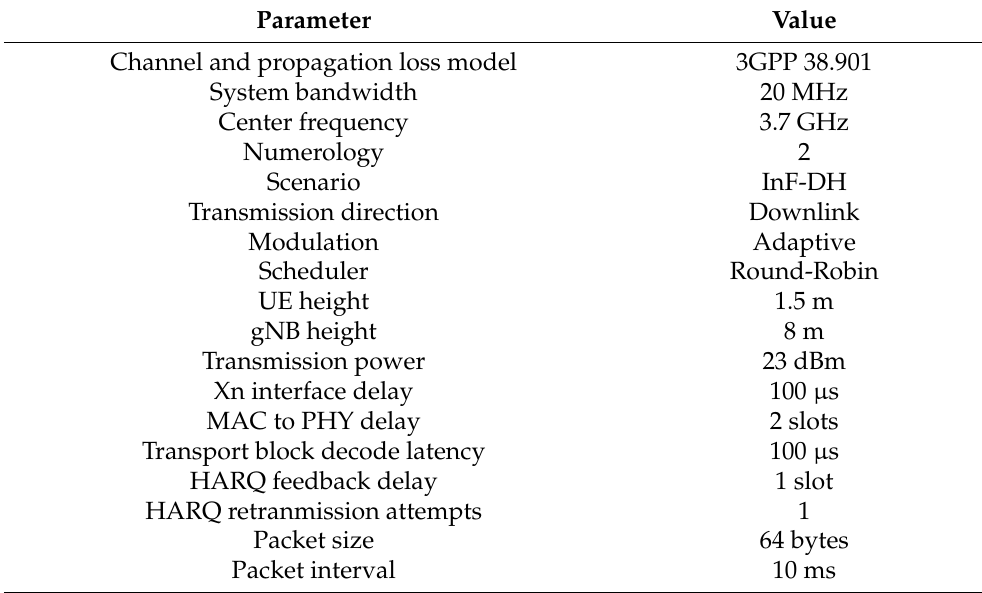
Table 1. The main configuration